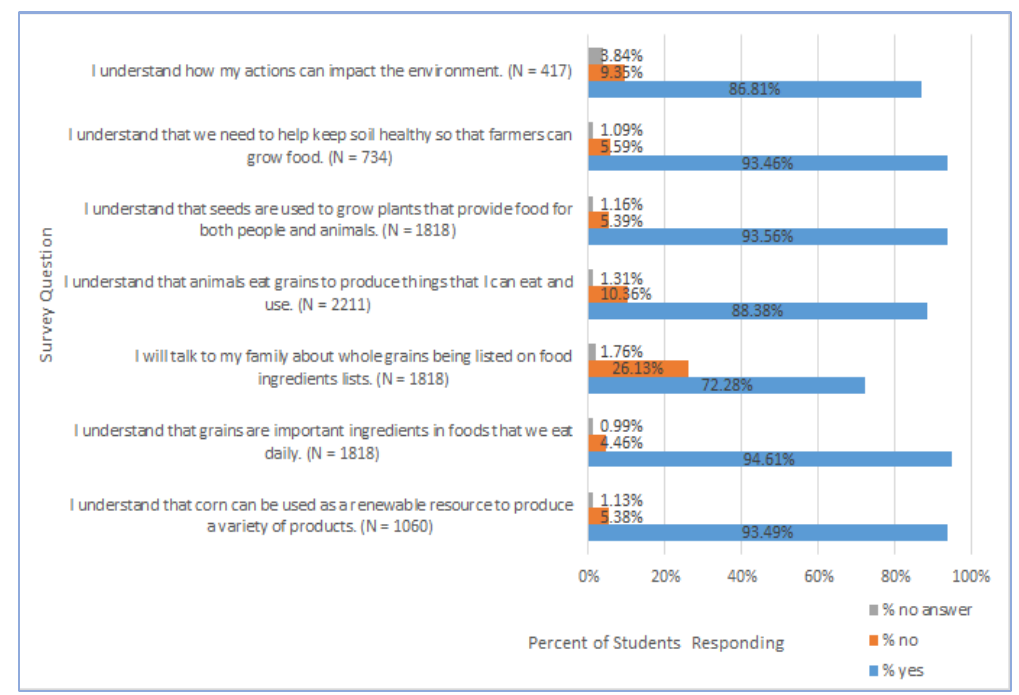
Figure 1. Student Survey